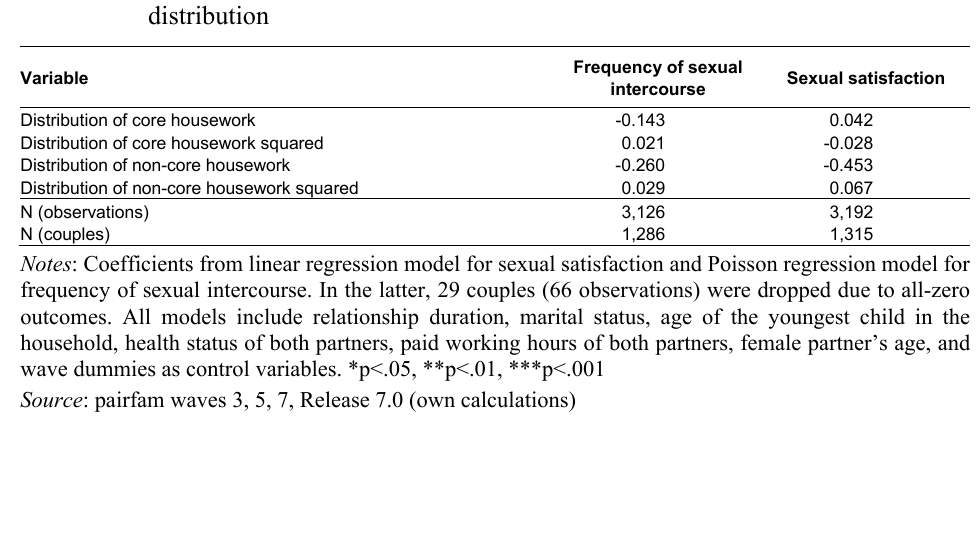
Table A.3 : Summary of fixed effects regression analyses estimating frequency of sexual intercourse and sexual satisfaction including a quadratic term of